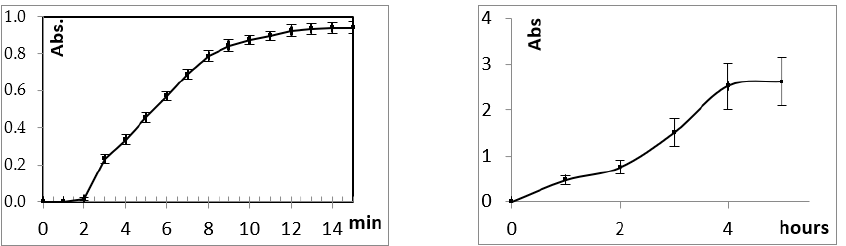
Figure 3. Kinetics of FbD degradation by the β -D-glucosidase enzyme from A. niger (480 nm, 37 °C)-left curve. Kinetics of FbD decomposition in diluted human saliva-right curve (480 nm, 37 °C).